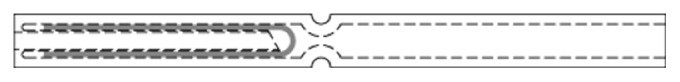
Laminar cup splitter design.